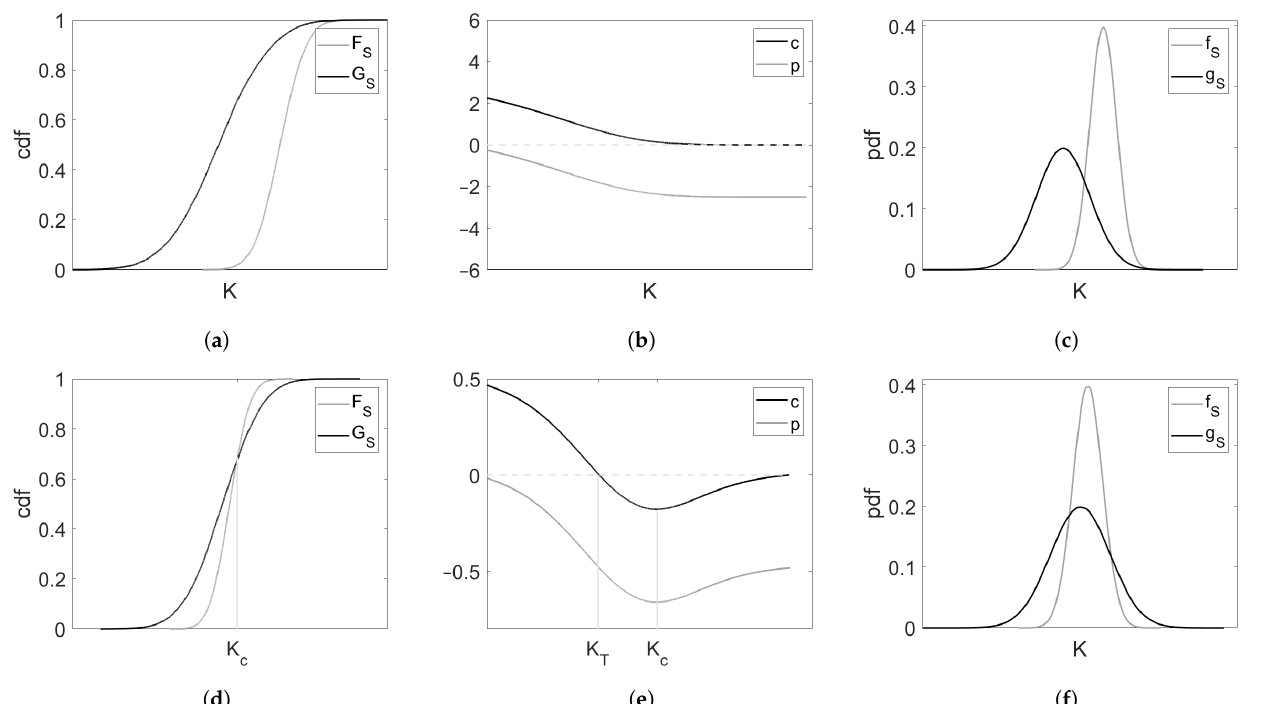
Figure 1. ( a ) Cumulative distribution functions F S and G S of asset S under, respectively, the physical measure P and the pricing measure Q . For all x ∈ ( 0, + ∞ ) it holds that F S ( x ) ≤ G S ( x ) . ( b ) Functions c and p resulting from the cumulative distribution functions in Figure 1a. ( c ) Density functions f S and g S resulting from the cumulative distribution functions in Figure 1a. ( d ) Cumulative distribution functions F S and G S under the condition that there exists exactly one x ∈ ( 0, + ∞ ) such that F S ( x ) = G S ( x ) . ( e ) Functions c and p resulting from the cumulative distribution functions in Figure 1d. ( f ) Density functions f S and g S resulting from the cumulative distribution functions in Figure 1d. ( a ) F S and G S ; ( b ); c and p ( c ) f S and g S ; ( d ) F S and G S ; ( e ) c and p ; ( f ) f S and g S